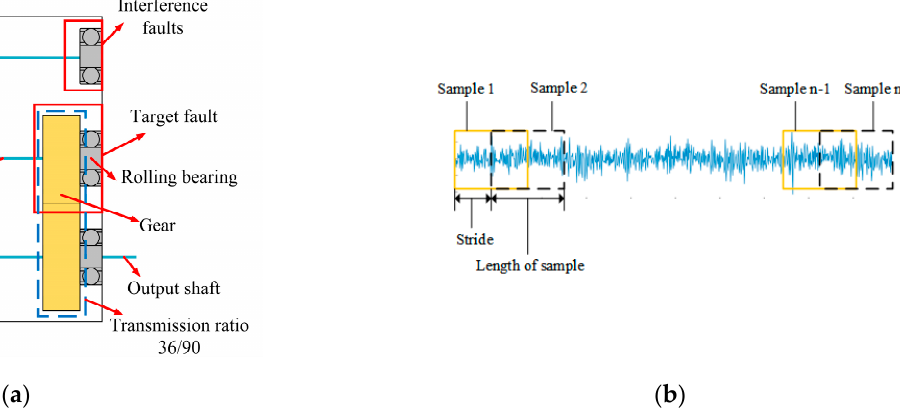
Figure 4. Experiment preparation. ( a ) Details of the fault arrangement. ( b ) Overlap sampling.